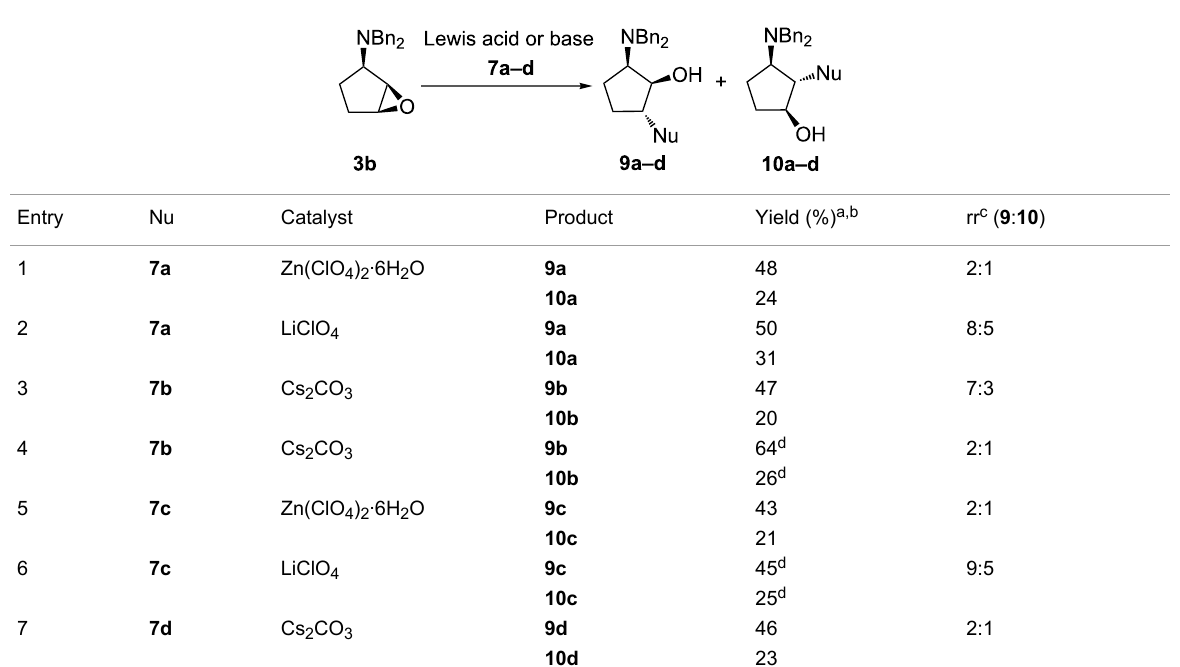
Table 2: Regioselectivity in the epoxide ring opening of 3b with nucleophiles.